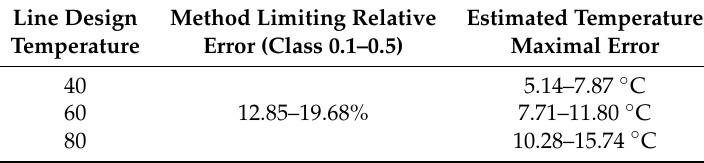
Table 7. Maximal absolute error for standard design temperatures of power lines at the sampling rate of 30 samples/min.